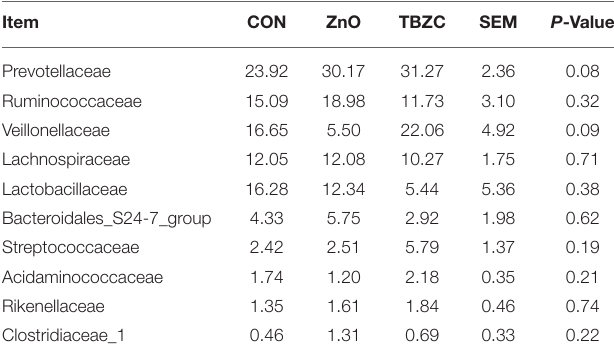
TABLE 6 | Effects of tetrabasic zinc chloride supplementation on relative abundance of fecal microbial community at family level in weaned piglets. Item CON ZnO TBZC SEM P